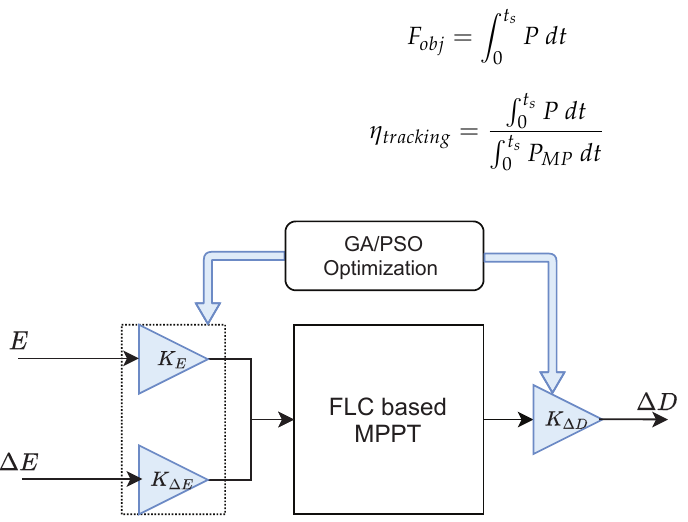
Figure 5. Optimization of the FLC gains.